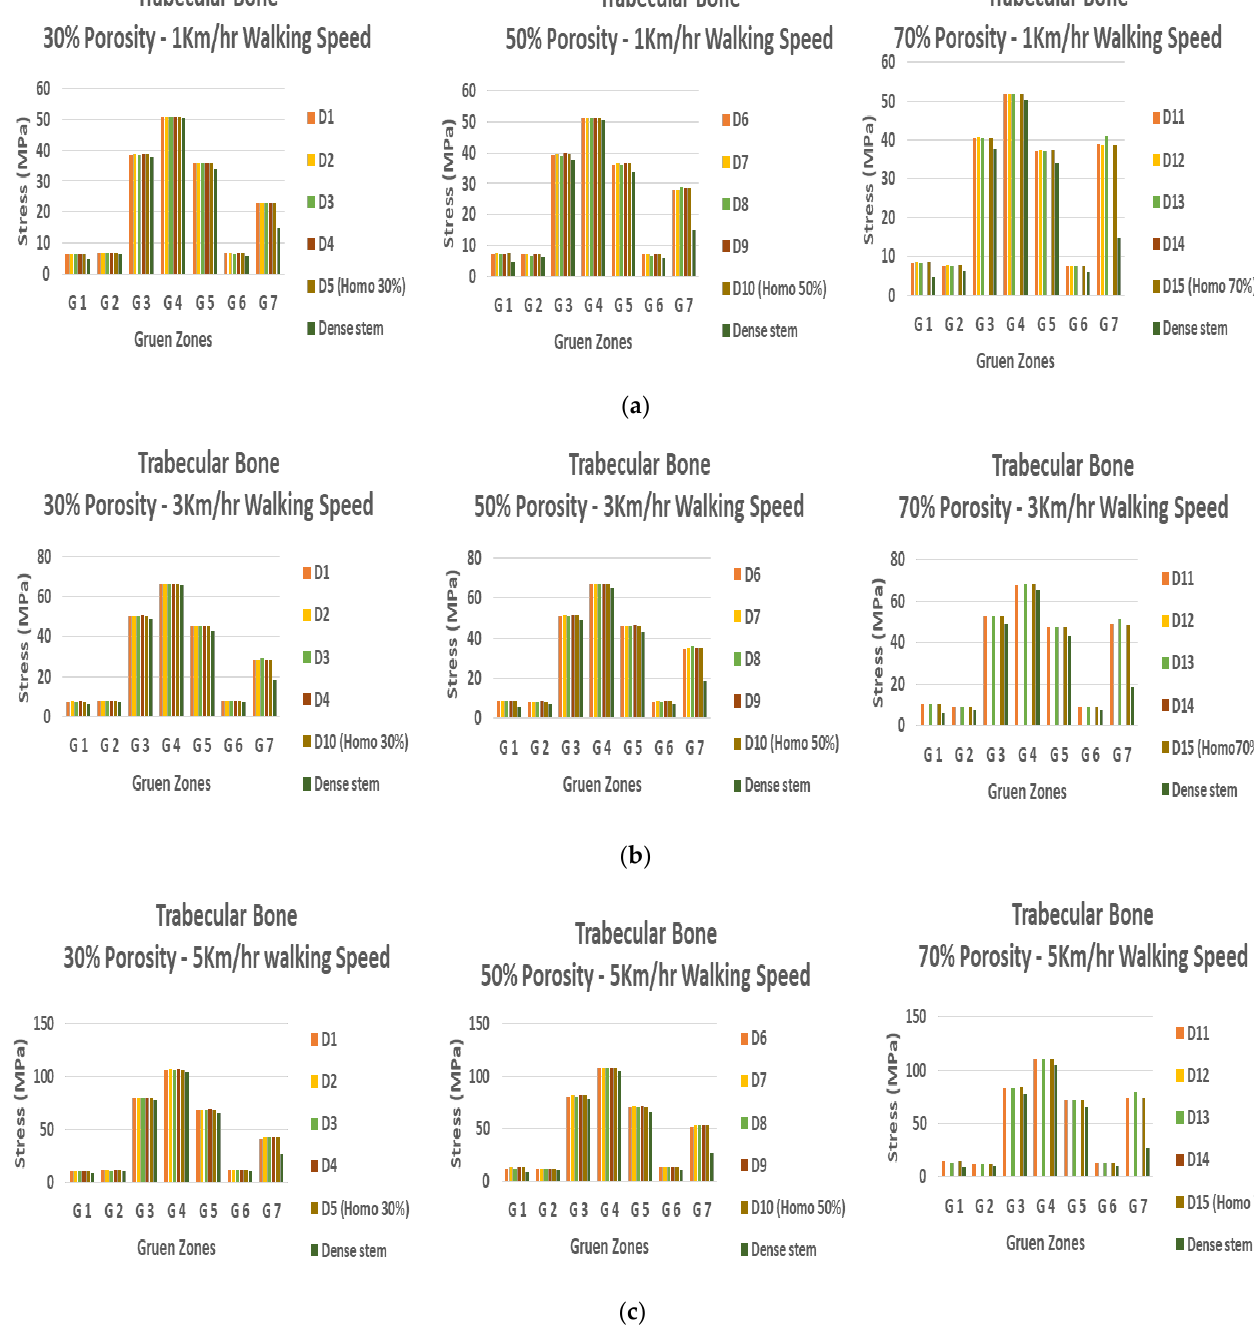
Figure 11. Stresses at Gruen zones of the functionally graded porous stems and the bulk Ti stem for proposed designs for different walking speeds: ( a ) 1 km/hr, ( b ) 3 km/hr, () 5 km/hr.